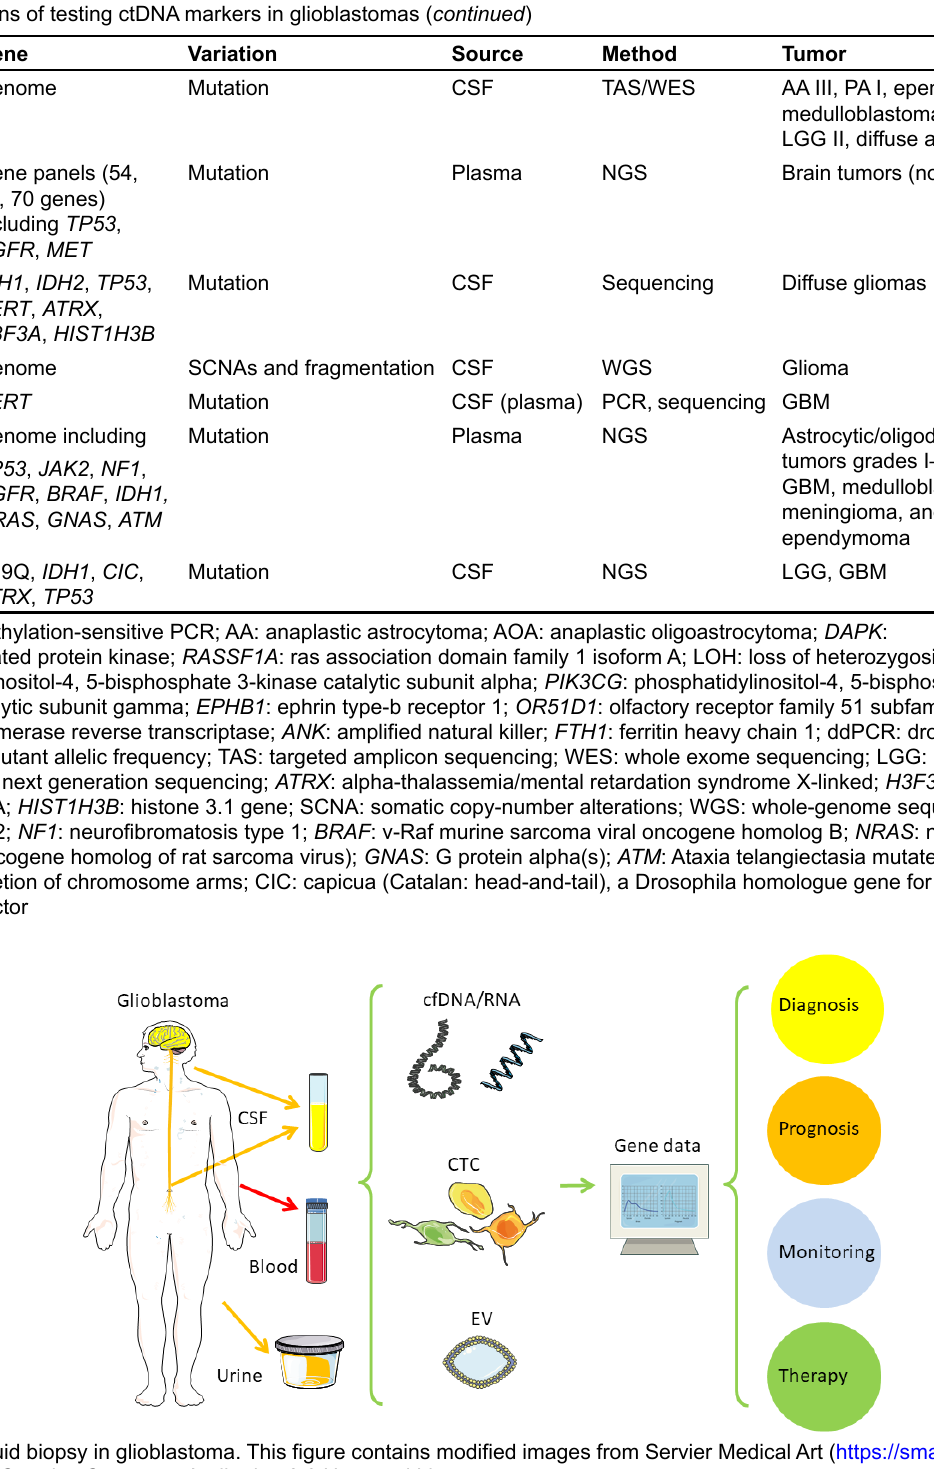
Figure 1. Liquid biopsy in glioblastoma. This figure contains modified images from Servier Medical Art (https://smart.servier.com) licensed by a Creative Commons Attribution 3.0 Unported License Note. Adapted from “Liquid biopsy and primary brain tumors,” by Eibl RH, Schneemann M. Cancers (Basel). 2021;13:5429 (https://doi.org/10.3390/cancers13215429). CC BY; “Liquid biopsy for monitoring medulloblastoma,” by Eibl RH, Schneemann M. Extracell Vesicles Circ Nucl Acids. 2022;3:263–74 (http://dx.doi.org/10.20517/evcna.2022.36). CC